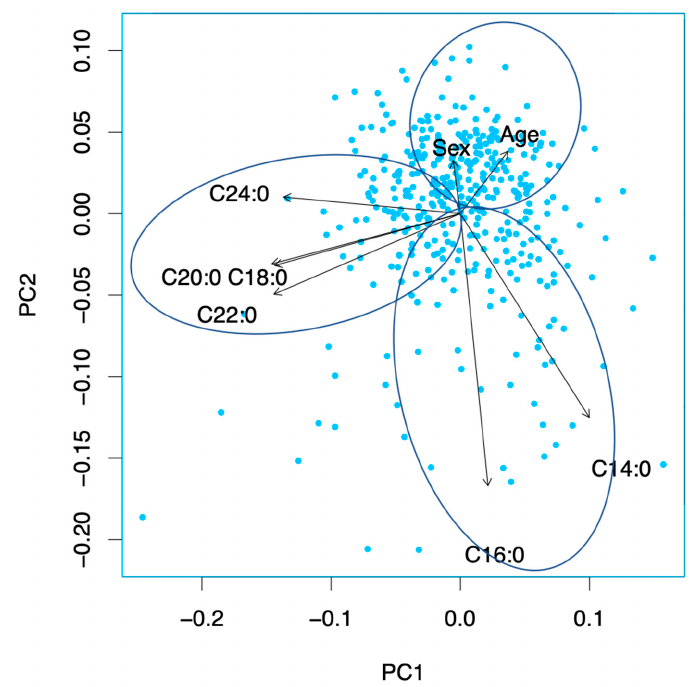
Figure 4. Principal component analysis. The first and second PCs are shown as biplot. The sum of variance of the first two principal components (PCs) was relatively low at 49.2%. The PCA